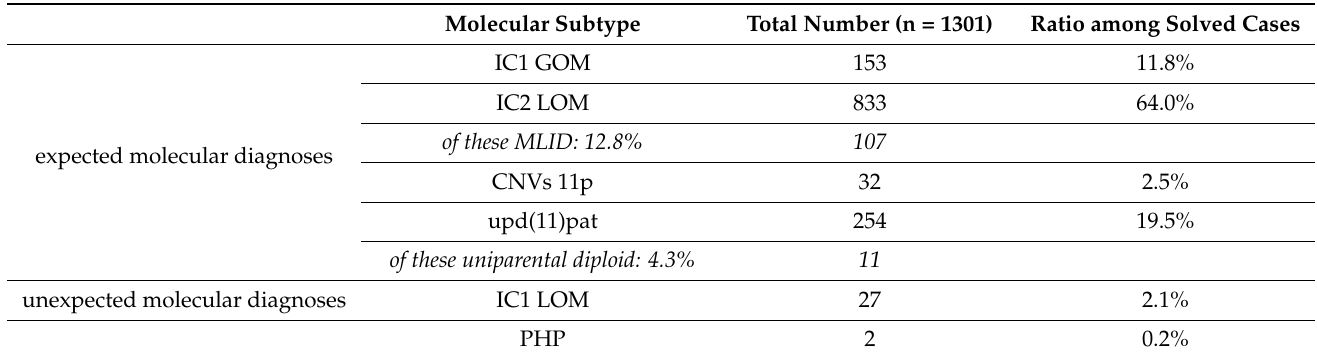
Table 1. Frequencies of the different molecular subtypes among molecularly confirmed patients with BWSp based on a recent survey from eleven diagnostic labs from seven countries (in preparation). Frequency of the mutation detection rates are not given as CDKN1C sequencing is not conducted routinely in all patients with the clinical diagnosis of BWS (For abbreviations: see text). Molecular Subtype Total Number (n = 1301) Ratio among Solved